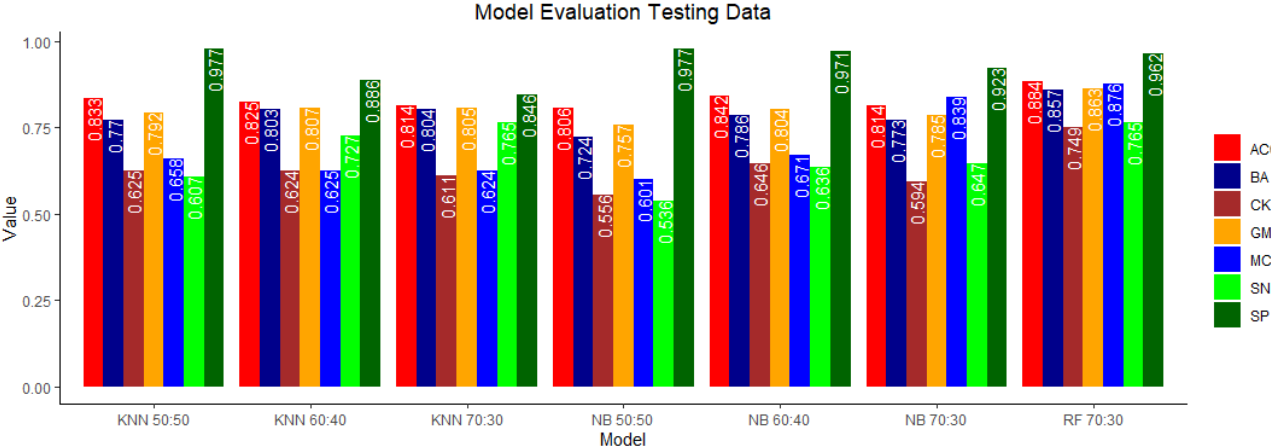
Figure 9. Result of evaluation of each model.